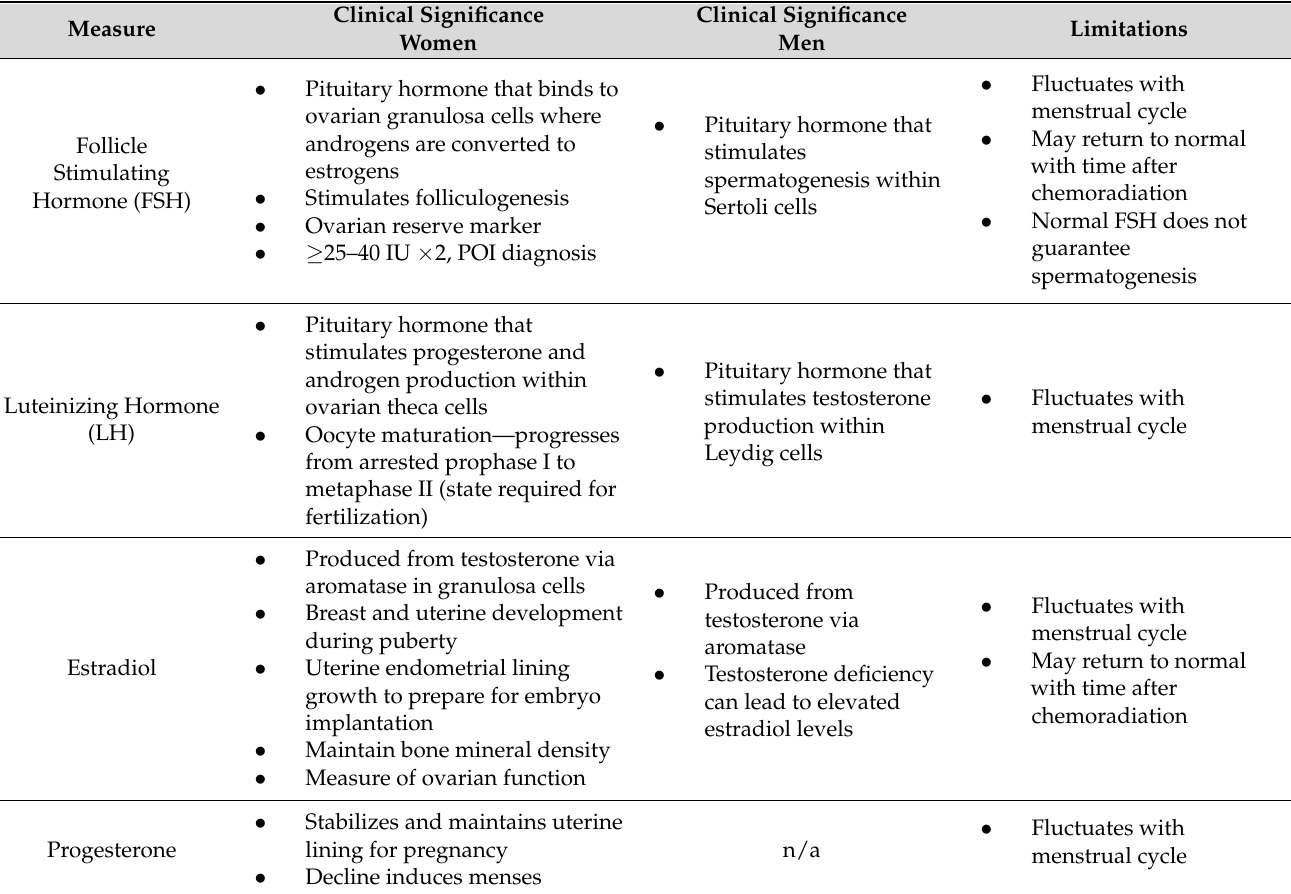
Table 1. Measures of Gonadal